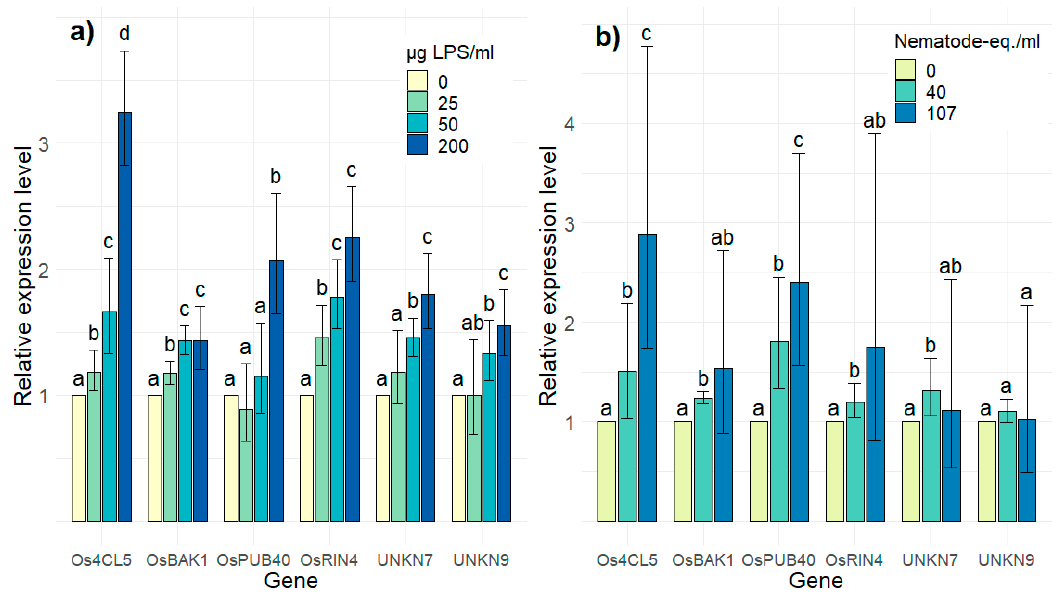
Figure 2. Relative expression levels of the final screening gene set in rice cell suspension cultures (RCSCs) upon a four-hour incubation with ( a ) 25, 50, and 200 µg LPS per mL cells and ( b ) 40 and 107 nematode-equivalents per mL cells. Expression levels were determined by RT-qPCR and are expressed relative to mock treated cells. RT-qPCRs were performed with three technical replicates on two biologically independent replicates. Error bars indicate the 95% confidence interval as calculated by Rest2009 software [40]. Accompanying letters indicate statistical differences, calculated per gene.